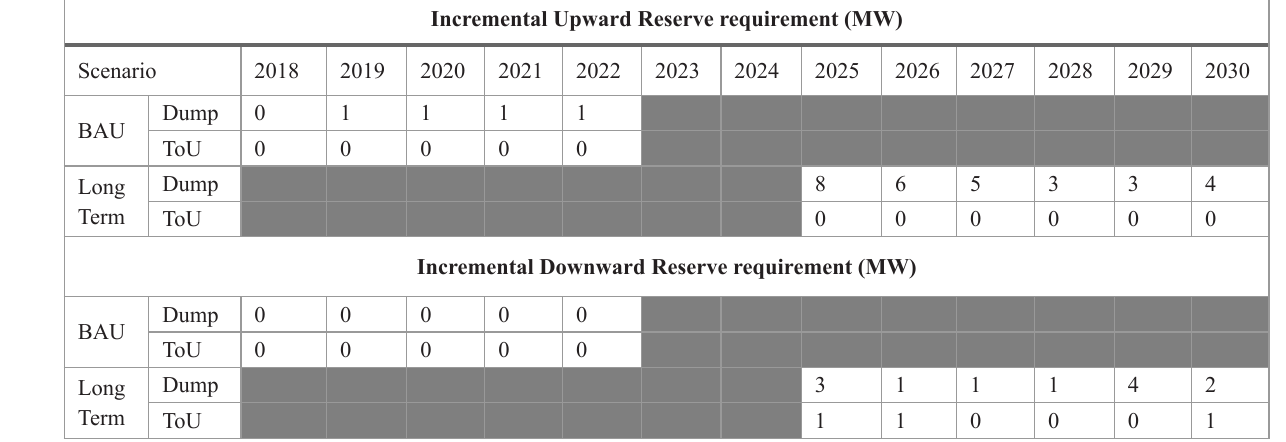
Table 1: Incremental Reserve requirement of Different scenarios and charging schemes. Incremental Upward Reserve requirement